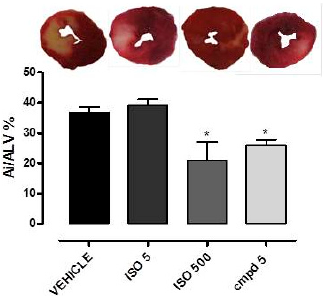
Figure 5. Morphometric quantification of ischaemia/reperfusion (I/R)-induced injury observed in ventricular slices of rat hearts, after acute myocardial infarction in vivo, after treatment with VEHICLE, ISO 500, ISO 5, or compound 5 . Asterisks indicate significant differences vs. vehicle (* p < 0.05).